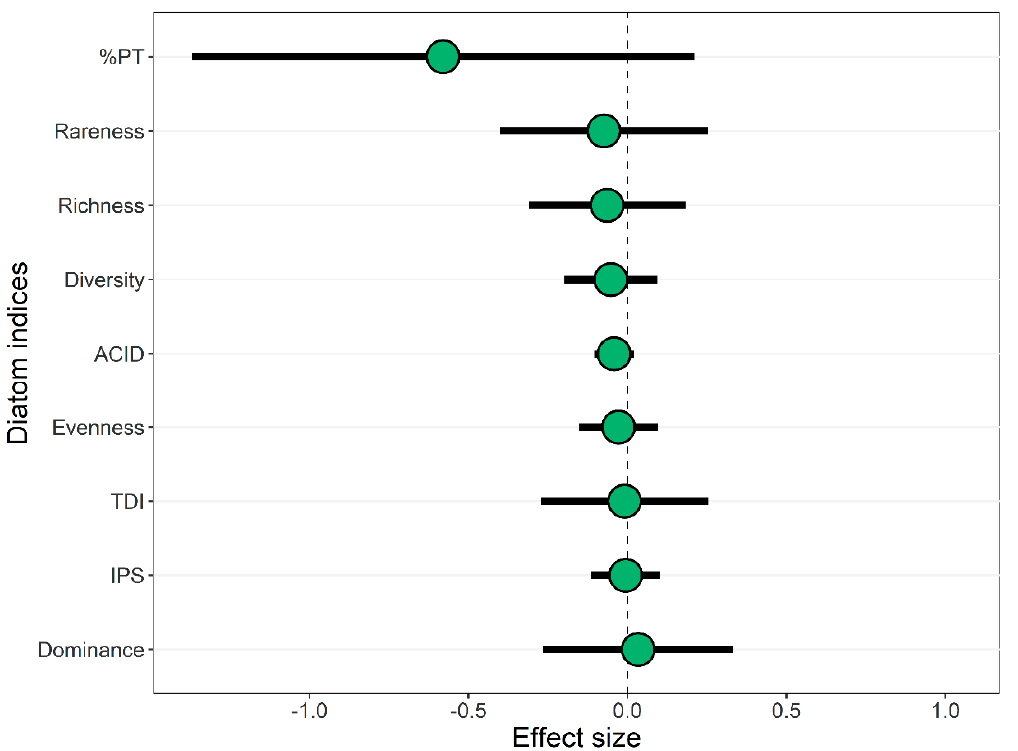
Figure 5. Effect sizes for differences in diatom-based indices between 10 pairs of unbuffered and buffered sites. Indices include standard diatom indices and α -diversity metrics. Only %PT showed a moderate negative effect size with present of riparian buffer. Effect sizes are expressed as mean log response ratios (with 95% CI). Rareness = Fisher´s alpha; Richness = species richness; Diversity = Shannon diversity; Evenness = Pielou’s evenness; Dominance = Berger-Parker dominance index.